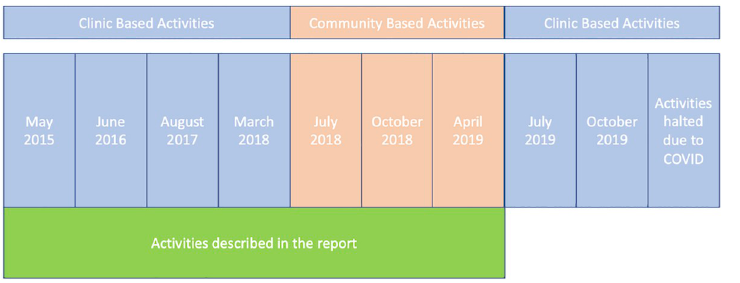
Fig 2. Timings of activities conducted by the DerMalawi Project